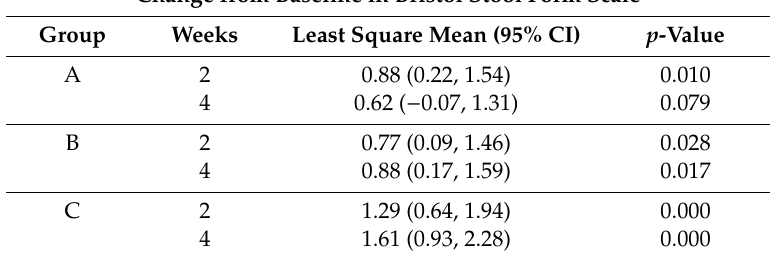
Table 3. Least square mean. The least mean square value is estimated by the linear mixed model, 95% confidence interval (95% CI), and p -value. In the t-test, the error is estimated by the linear mixed model. The null hypothesis was subjected to a two-sided test. Group A: Lactobacillus reuteri DSM 17938; group B: combination; group C: magnesium